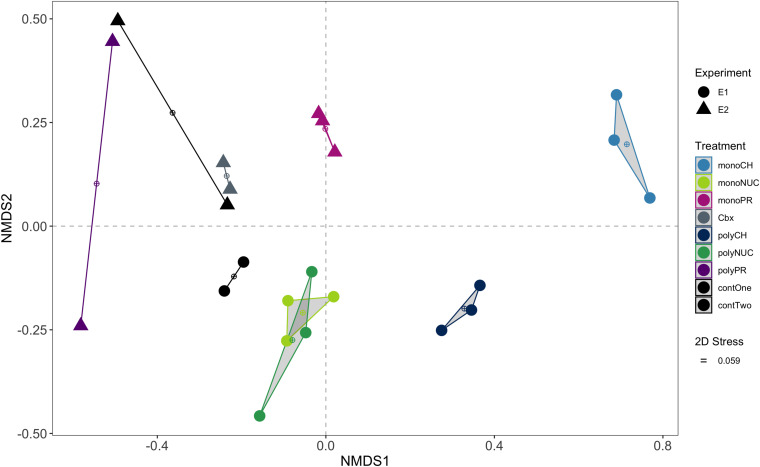
Non-metric multidimensional scaling (NMDS) ordination of functional genes based on pairwise Bray-Curtis distances of normalized counts per million (cpm). Convex hulls group biological replicates within treatments. Experiment 1, E1 (conducted on February 16th, 2016); experiment 2, E2 (performed on March 15th, 2016); monoCH, monosaccharide mix; monoNUC, nucleotide mix; monoPR, amino acid mix; Cbx, carboxylic acid mix, polyCH, polysaccharide mix; polyNUC, DNA; polyPR, polypeptides; contOne and contTwo, controls from experiment 1 and 2, respectively.